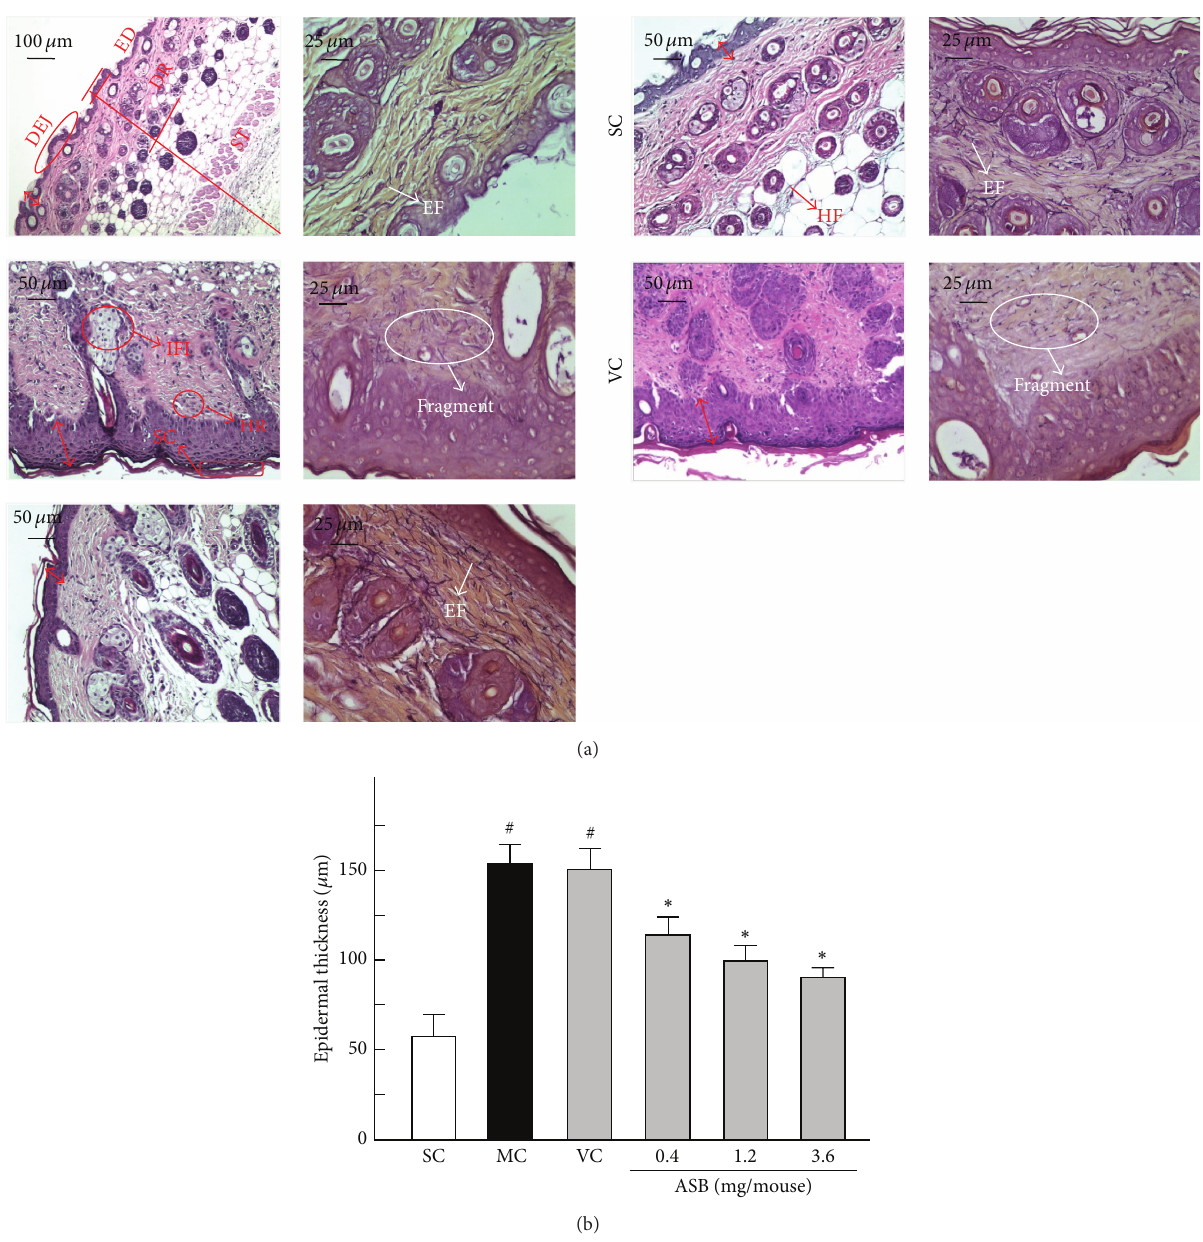
Figure 3: Evaluation of skin histological observation at the end of experiment period. (a) (left) H&E staining of mice skin for routine examination. (a) (right) Gomori’s aldehyde fuchsin staining of mice skin. Epidermal thickness was shown via the double-headed red arrows. ED, epidermis; DR, dermis; ST, subcutaneous tissue; DEJ, dermal-epidermal junction; SC, stratum corneum; HF, hair follicle; HR, hemorrhage; IFI, inflammation infiltration; EF, elastic fibers. (b) Histogram presentation of the results of average epidermal thickness of each group at the end of experiment period. Data represents means ± SD ( 𝑛 = 8 ). # 𝑝 < 0.05 compared with the SC group; ∗ 𝑝 < 0.05 compared with the VC group. NC, normal control; SC, sham control; MC, model control; VC, vehicle